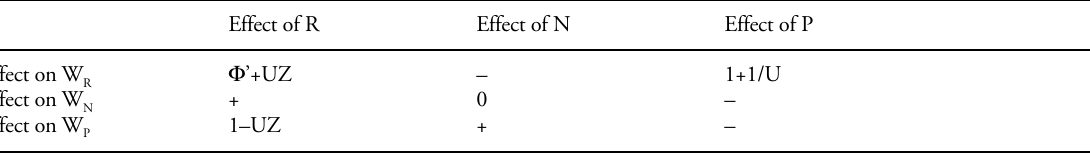
Table 1. Inter- and intra-specific effects. U = N/(B” R 2 ), Z = ∂ / ∂ C (C B’ ). The sign of Z determines whether intermediate predators N N N N increase or decrease their foraging effort with respect to basal prey density. + (always positive), – (always negative), 0 (does not affect). When an expression is given, the sign of the expression determines the effect. Effect of R Effect of N Effect of P Effect on W